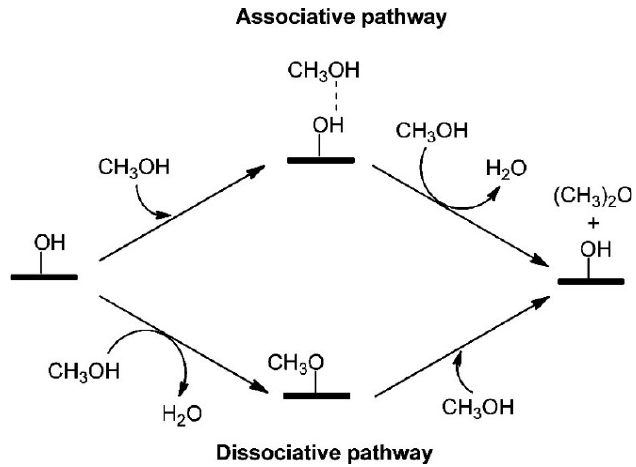
Figure 1. The associative and dissociative pathways of methanol (MeOH) dehydration. Reprinted with permission from [21]. Copyright (2015) American Chemistry Society.